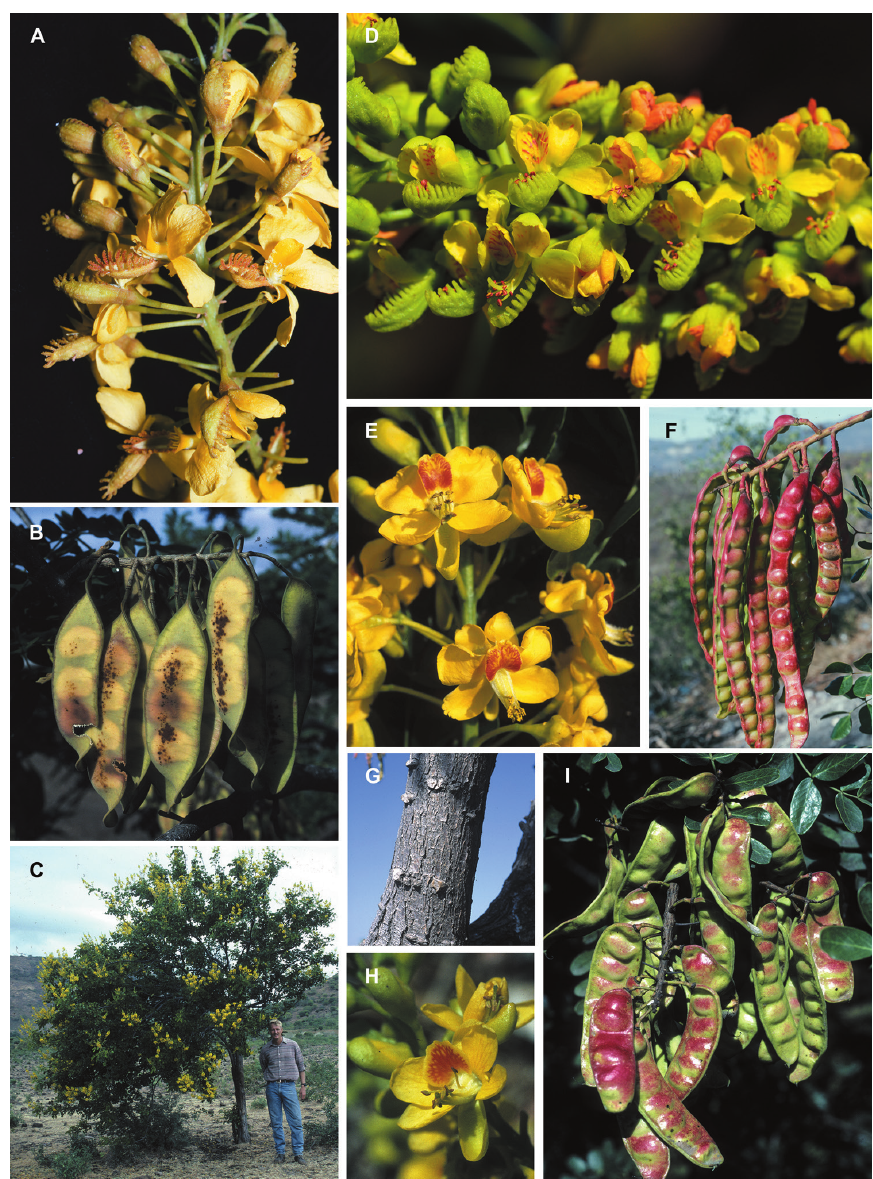
Figure 14. Caesalpinia ( Coulteria ) velutina Britton & Rose. A inflorescence (G. P. Lewis, Guatemala, Lewis et al. 1713 (K)) B fruits (C. E. Hughes, Guatemala, Lewis et al. 1714 (K)). Tara vesicaria (L.) Molinari, Sánchez Och. & Mayta C habit (C. E. Hughes, Tecolostote, Nicaragua, Hughes 1376 (FHO)) H flower (C. E. Hughes, Rivas, Nicaragua, J. A. Hawkins 11 (FHO). Tara spinosa (Molina) Britton & Rose D inflorescence (E. Gagnon, Ancash, Peru, Hughes et al. 3043 (MT)) I unripe fruits (C. E. Hughes, Cajamarca, Peru, Hughes 1996 (FHO)). Tara cacalaco (Humb. & Bonpl.) Molinari & Sánchez Och. E flowers (C. E. Hughes, Puebla, Mexico, Hughes et al. 2169 (FHO) ) F unripe fruits (G. P. Lewis, Mexico, MacQueen 488 (K) ) G bark (C. E. Hughes, Puebla, Mexico, Hughes et al. 2073